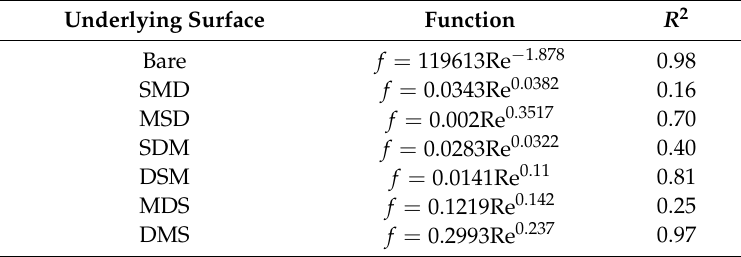
Figure 5. Relationship between the Darcy–Weisbach friction coefficients and Reynolds numbers. Table 4. Regression functions of the Darcy–Weisbach friction coefficients ( f ) and Reynolds numbers ( Re ) for each experimental arrangement.